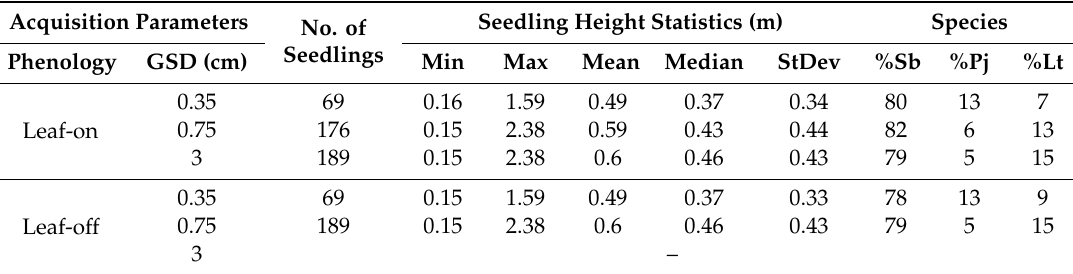
Table 1. Drone acquisition parameters and descriptive statistics of ground-measured heights for seedlings used in the analysis of each drone dataset. GSD = ground sampling distance, Sb = black spruce, Pj = jack pine, Lt = larch. NB. The di ff erent number of seedlings in the 0.75 cm GSD leaf-on and leaf-o ff acquisitions, and the di ff erent minimum height in the 0.35 cm GSD leaf-on acquisition are due to them having slightly di ff erent